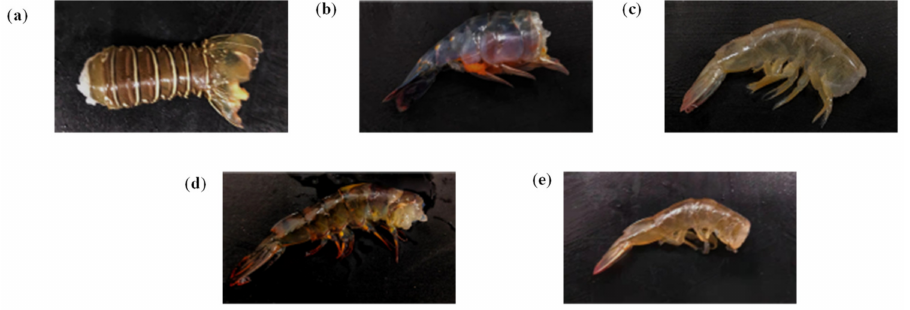
Figure 8. Photos of five different shrimp species. ( a ) Panulirus argus; ( b ) Macrobrachium rosenbergii; ( c ) Penaeus chinensis; ( d ) Penaeus japonicus; and ( e ) Metapenaeus